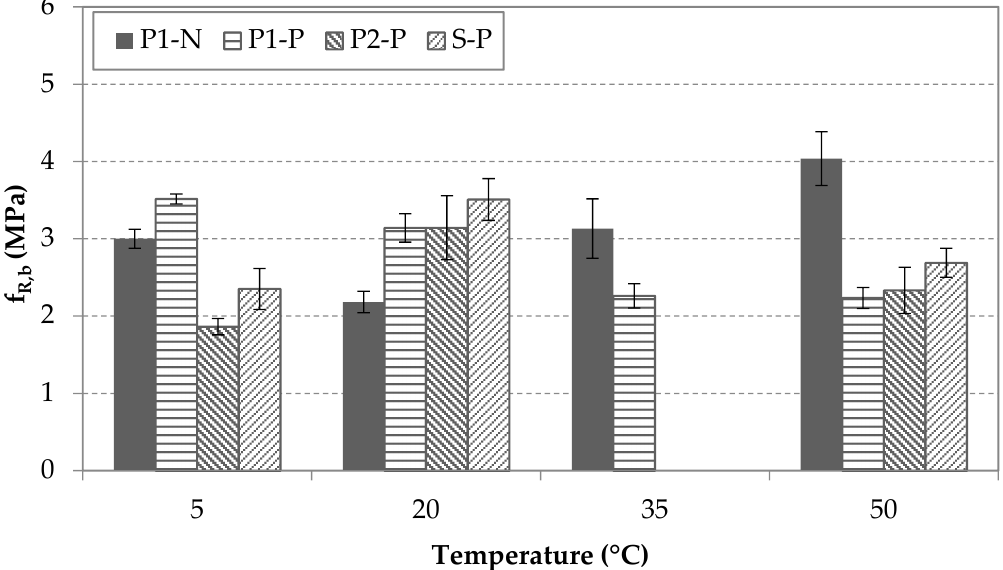
Figure 10. Results of f R,b for each type of fiber and condition at different temperatures.